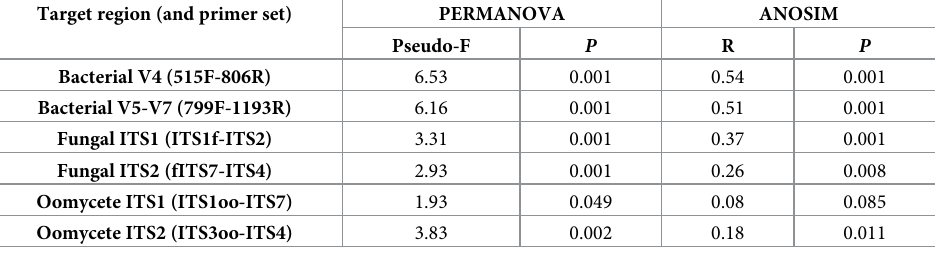
Table 4. Effects of the PRD-inducing capacity of non-treated soil on bacterial, fungal, and oomycete root commu- nity composition, as revealed by PERMANOVA (permutational analysis of variance) and ANOSIM (analysis of similarity) of Bray-Curtis dissimilarities a